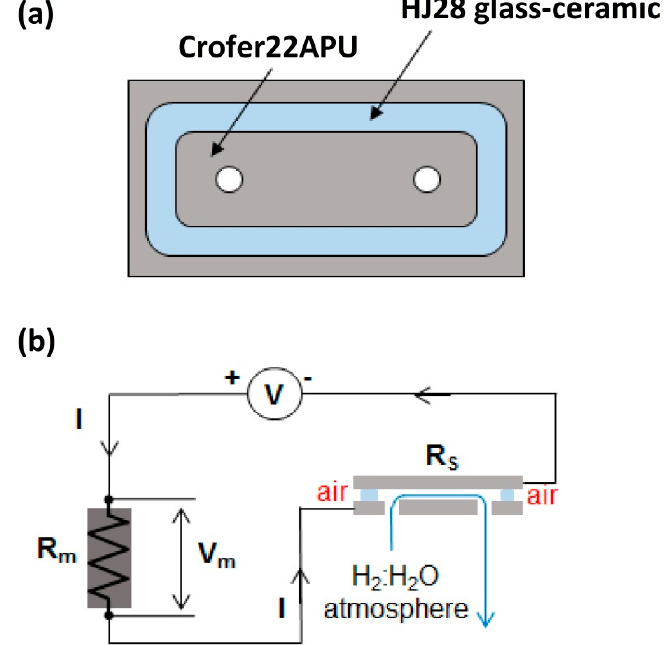
Figure 1. ( a ) Schematic of sample and ( b ) measuring setup, for the electrical resistivity analysis in dual atmosphere.